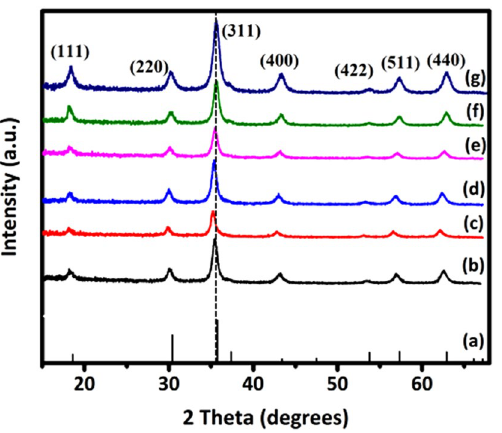
Figure 2. ( a ) Diffraction peaks corresponding to the JCPDS card #96-591-0,064 and XRD patterns of Ni 1−x Mn x Fe 2 O 4 nanoparticles where ( b ) x = 0, ( c ) x = 0.2, ( d ) x = 0.4, ( e ) x = 0.6, ( f ) x = 0.8, and ( g ) x =